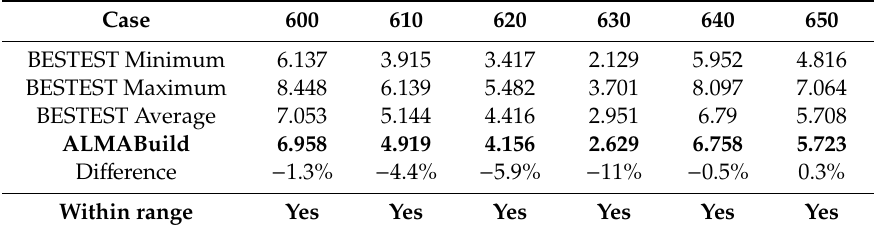
Table 4. Annual Cooling Load (MWh) obtained for non-free-float lightweight BESTEST cases compared with the minimum and maximum threshold values indicated by